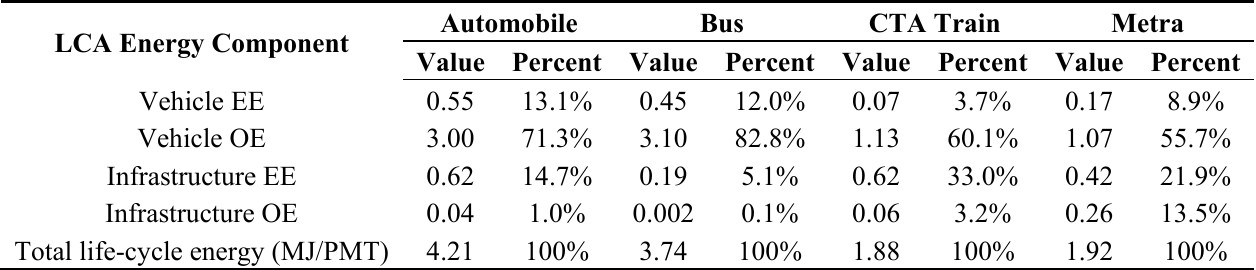
Table 8. Assumptions of energy use per passenger-mile-traveled (MJ/PMT) for multiple transportation modes from